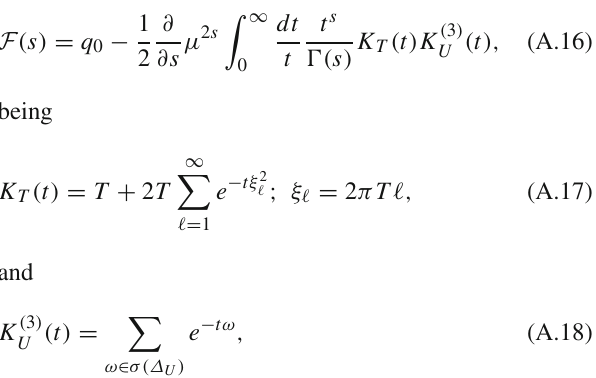
Fig. 14 Graphical representation of Δ T F /Δ ( 0 ) the parameter (cid:19) in the subset { α = − θ + (cid:19),θ, n 1 = 1 } , as given by Eq. (32) (solid line in red), and their asymptotic approximations of Eq.